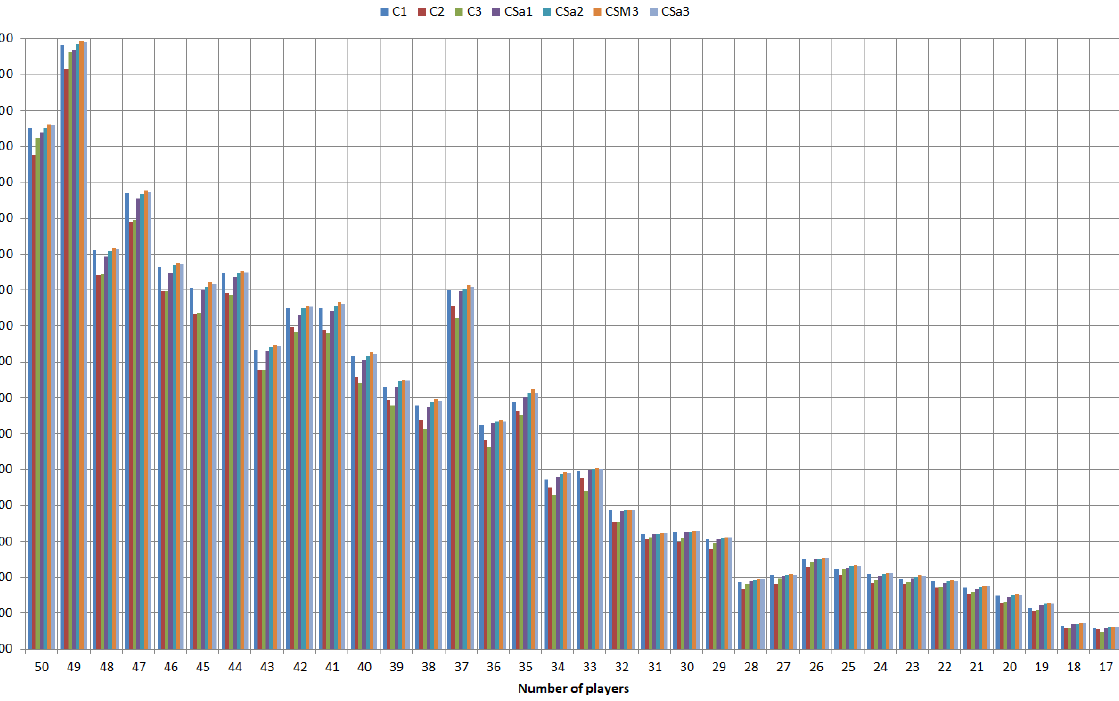
Figure 5. Sub-optimal tournament costs determined by sub-optimal algorithms on different quotations’ sequences for various number of